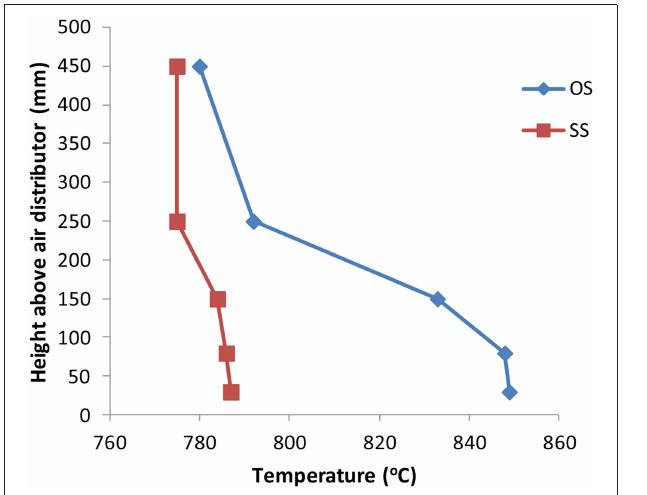
FIGURE 2 | Temperature profiles of the fuels along the reactor height at F = 0.72 kg/h and λ = 1.4.